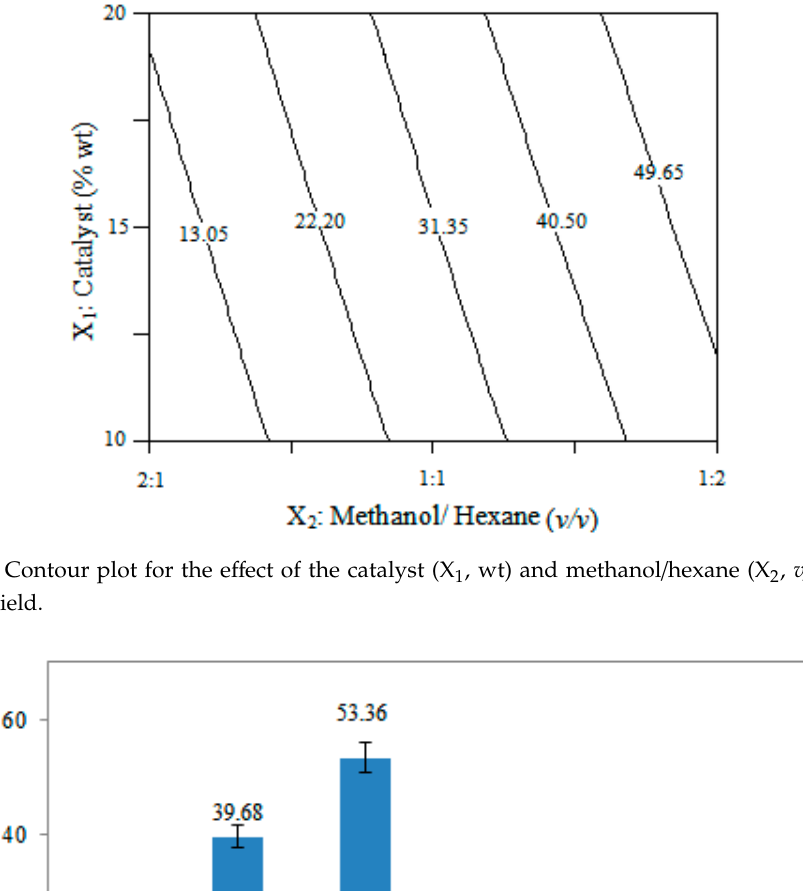
Table 3. ANOVA of the microalgae biomass transesterification model.